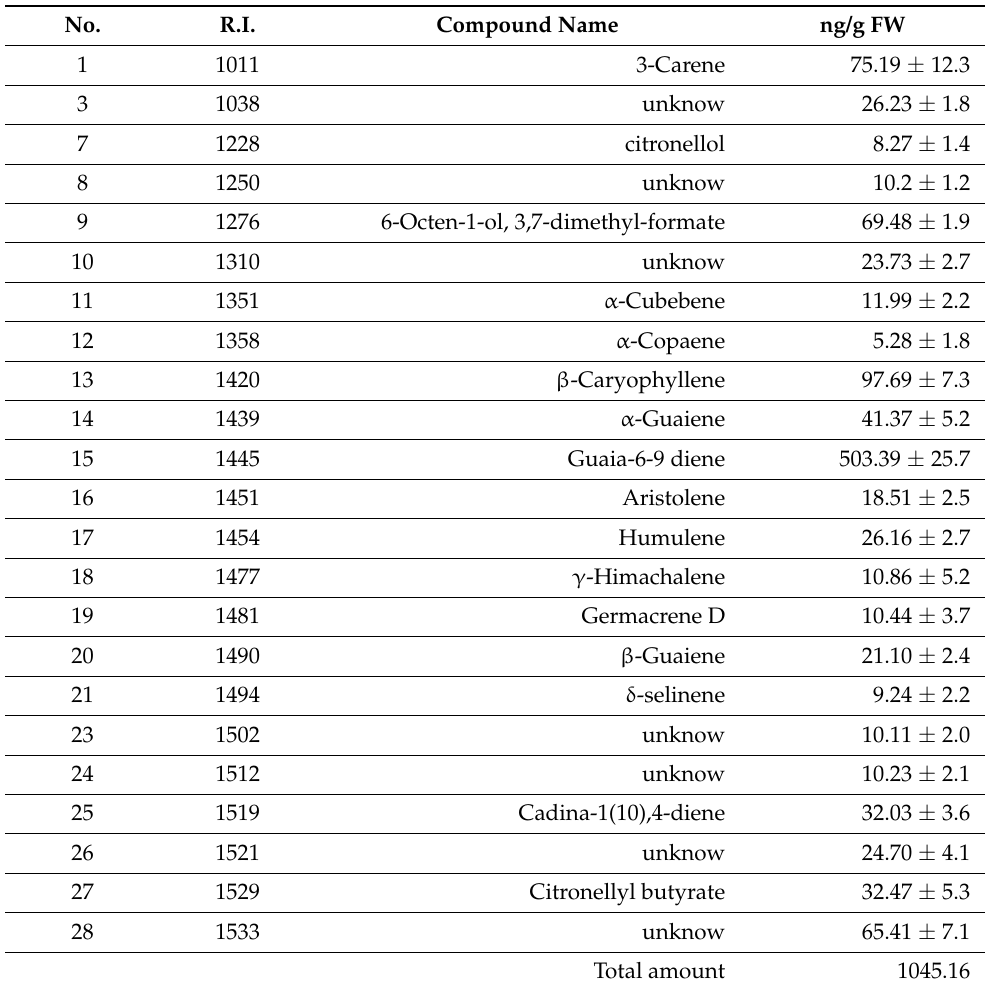
Table 6. Volatile organic compounds produced by P. ‘Endsleigh’ sepals at full bloom and their semi-quantitative determination (ng/g